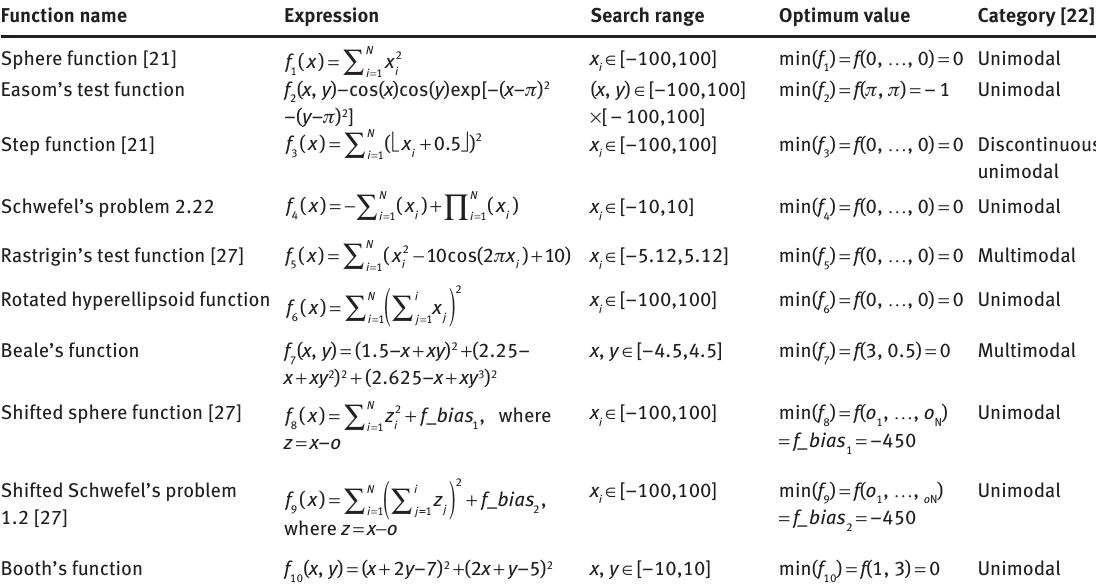
Table 9: Benchmark Functions used to Evaluate the Algorithms. Function